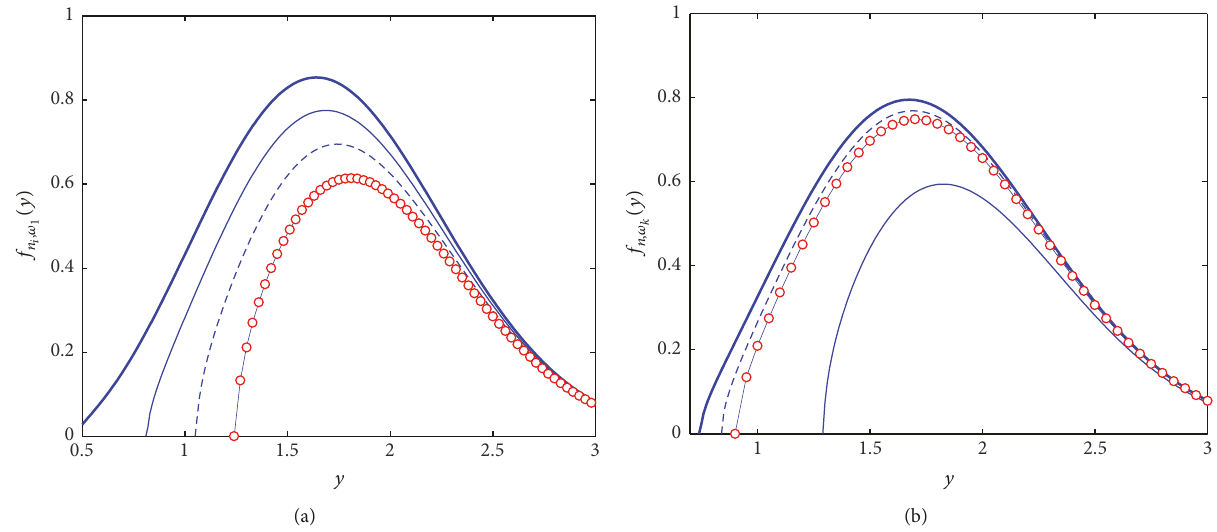
= 52 cm −1 for 𝑛 = 0, 1, 2,3 increasingdownwards. 1 ] = 157 cm −1 , 𝑛 = 0 , and 𝑓 ] = 176 cm −1 , 𝑛 = 0 , 0,𝜔 4 for 4 0,𝜔 6 for 6